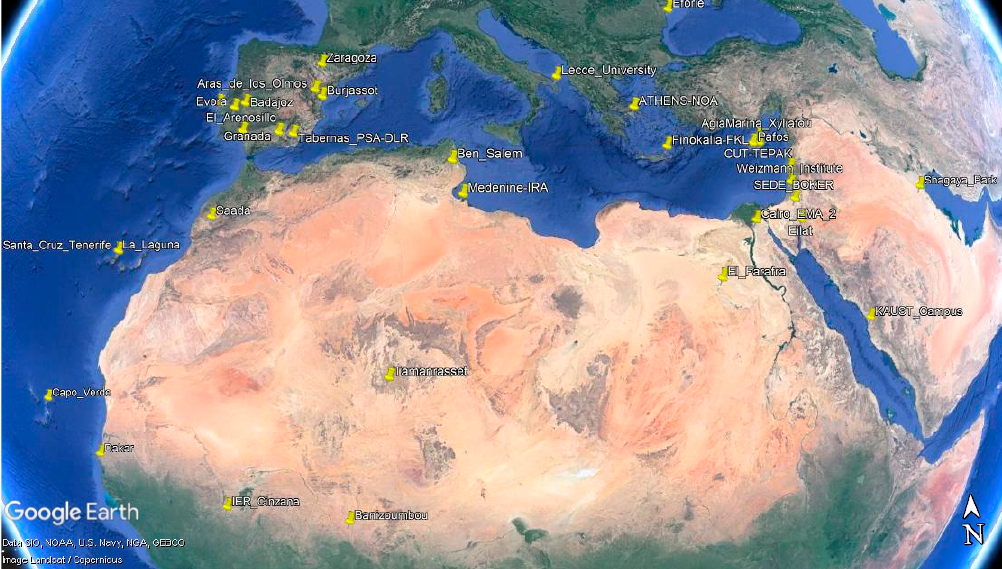
Figure 3. Positions of the 34 AERONET stations used for this study